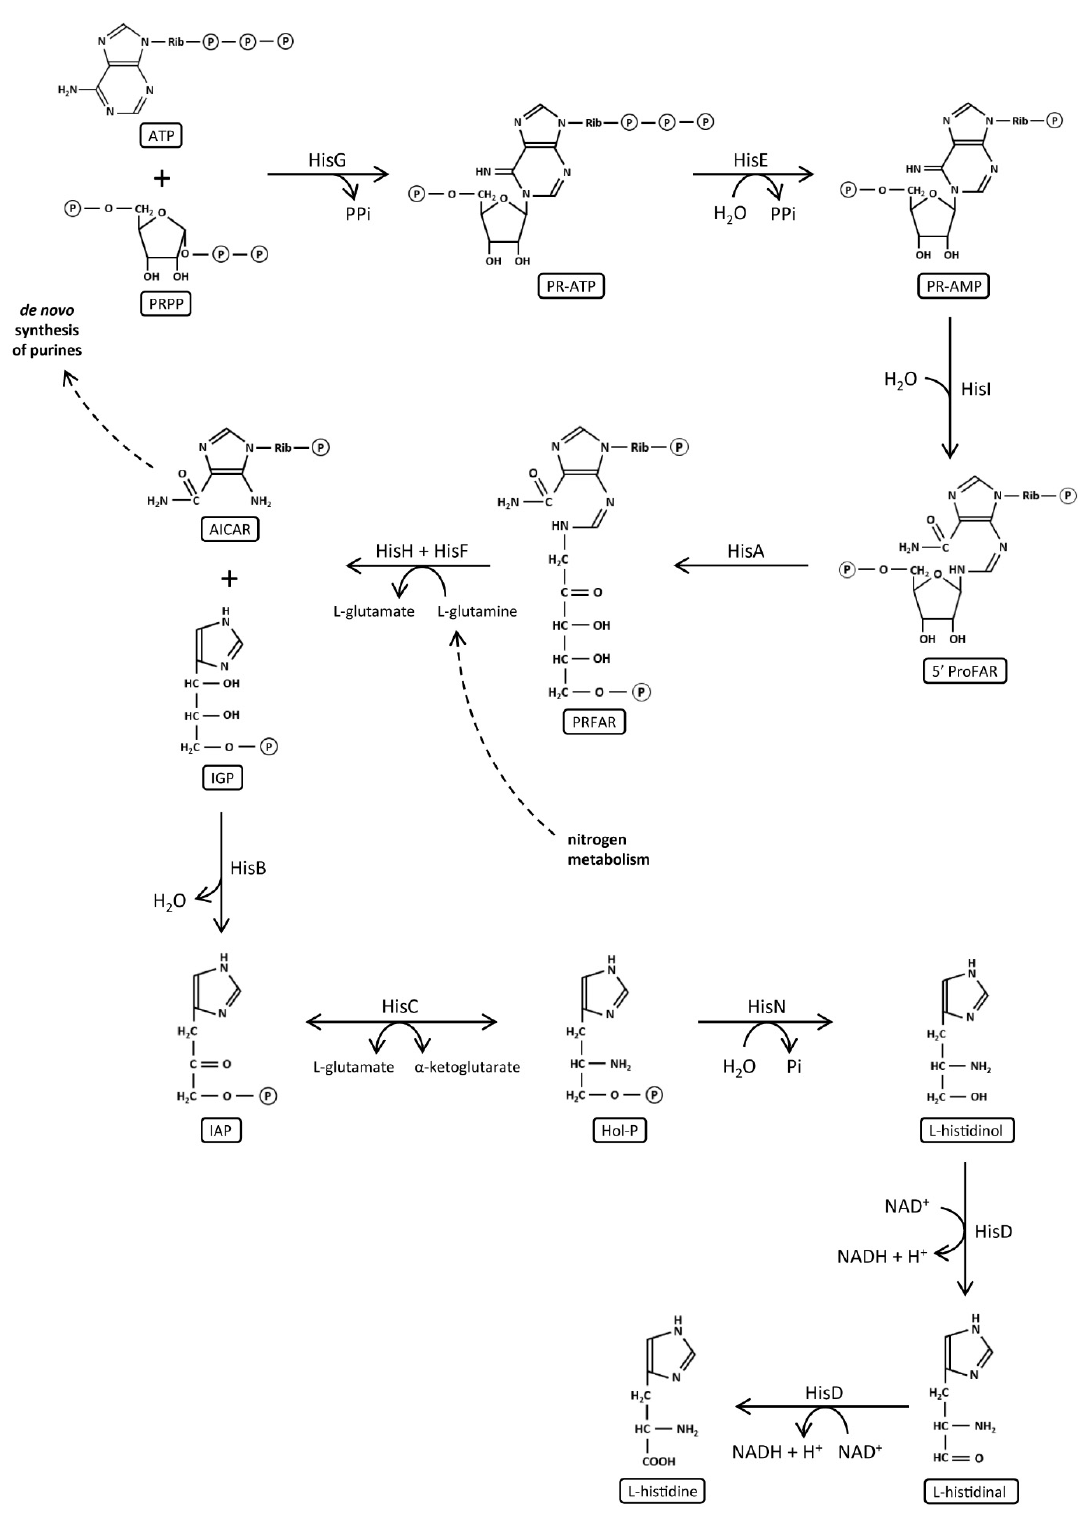
Figure 2. Biosynthetic pathway of L-histidine. Representation adapted from Kulis-Horn et al. [16] and Alifano et al. [17].